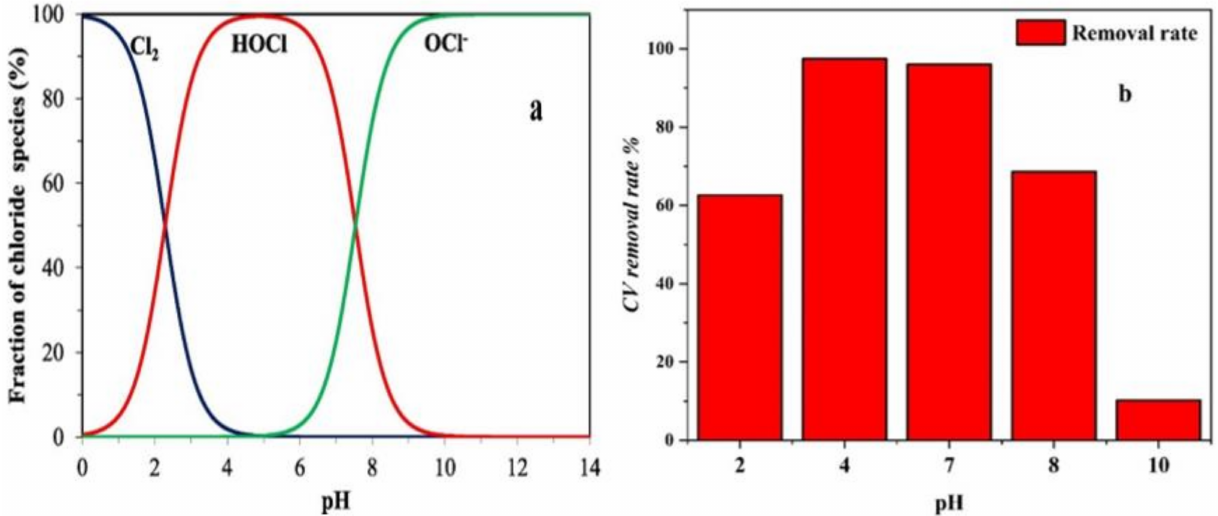
Figure 6. ( a ) Diagram of predominance of the chlorinated species [48]; ( b ) reduction of CV as a function of adjusted initial pH ([CV] 0 = 10 mg L − 1 , i = 50 mA cm − 2 and temperature = 25 ◦